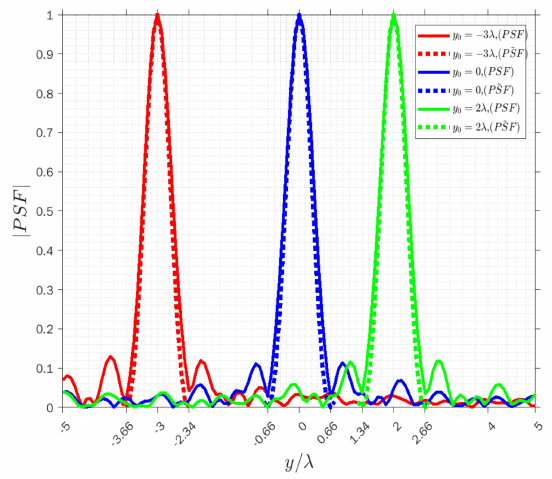
Figure 4. Comparison of the normalized amplitude of the actual (solid lines) and approximated (dashed lines) PSFs for y 0 = − 3 λ (red lines), y 0 = 0 (blue lines) and y 0 = 2 λ (green lines) when x = − λ in receiving mode.